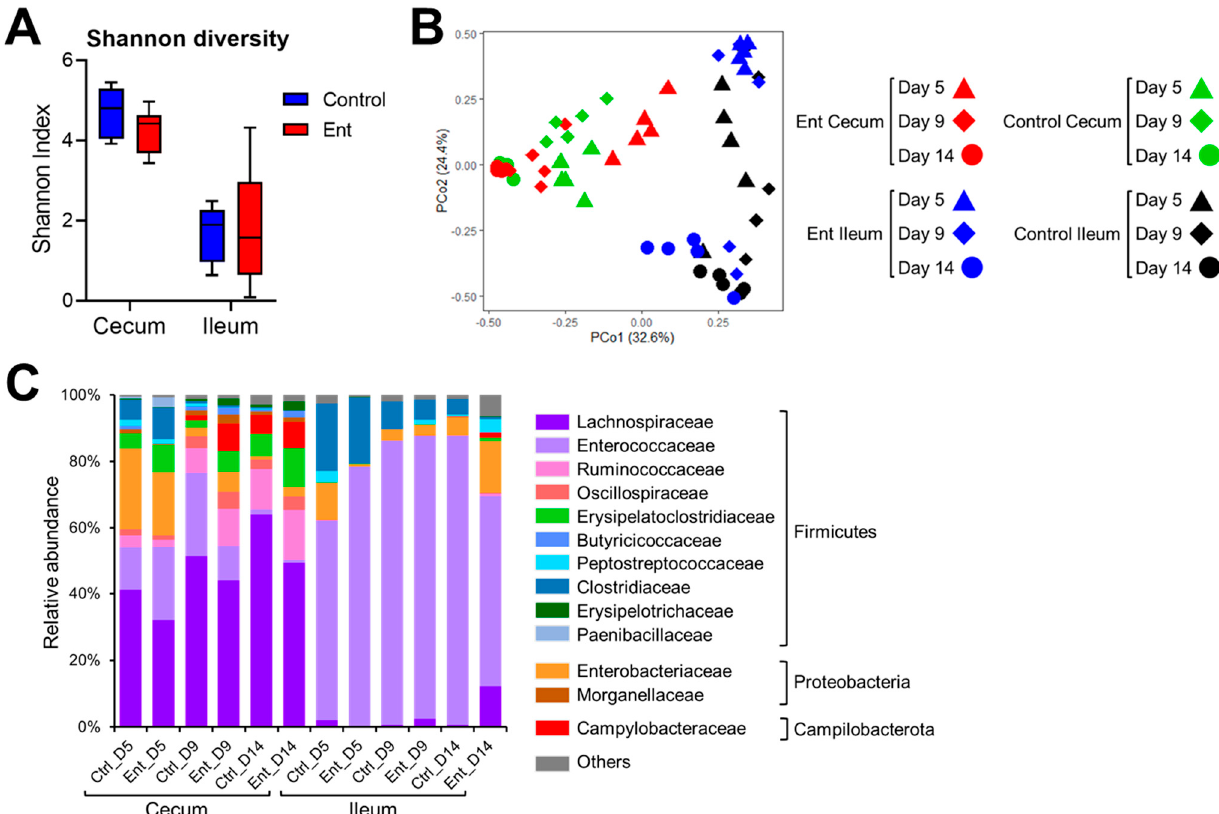
Figure 2. Analysis of intestinal microbiota in chickens using 16S rRNA gene amplicon sequencing. ( A ) Shannon diversity of bacterial community in the cecum and ileum. ( B ) Principal coordinate analysis, based on Bray–Curtis distance, on microbiota structure in the cecum and ileum. ( C ) Relative abundance of specific family/phylum in the cecum or ileum of the chickens in two groups at different time points. Each bar represents the averaged abundance of five samples within each group.